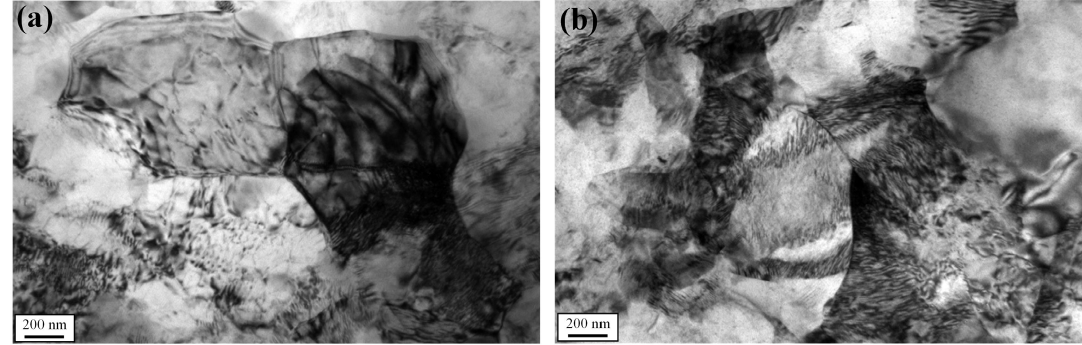
Fig. 4. TEM micrograph of rolled sheets showing DRX-ed grains: (a) Ingot, and (b) TRC.